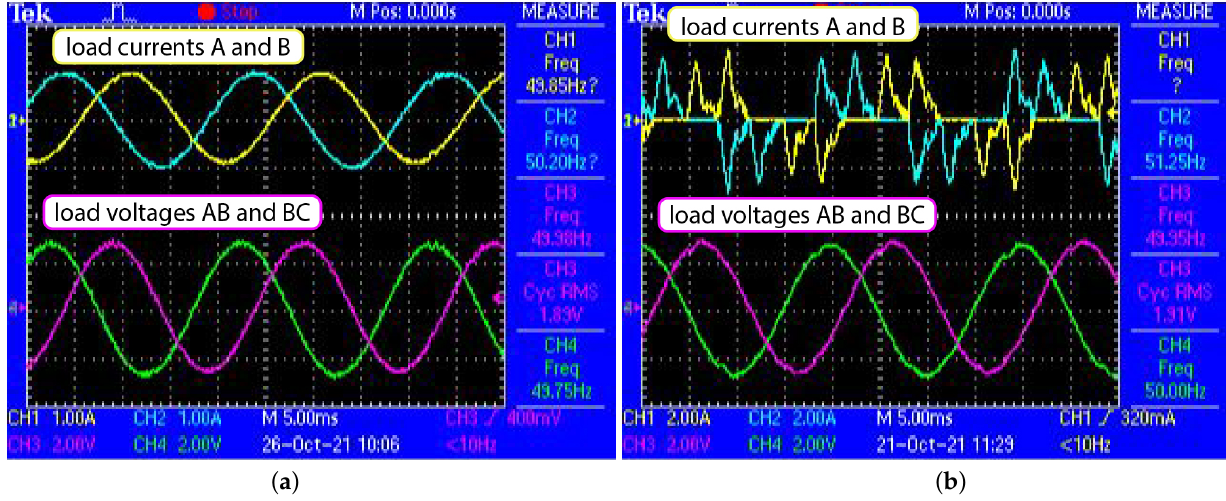
Figure 30. UPS Inverter prototype experimental waveforms with linear and non-linear loads, acquired with the the oscilloscope. ( a ) Linear Load. ( b ) Non-Linear